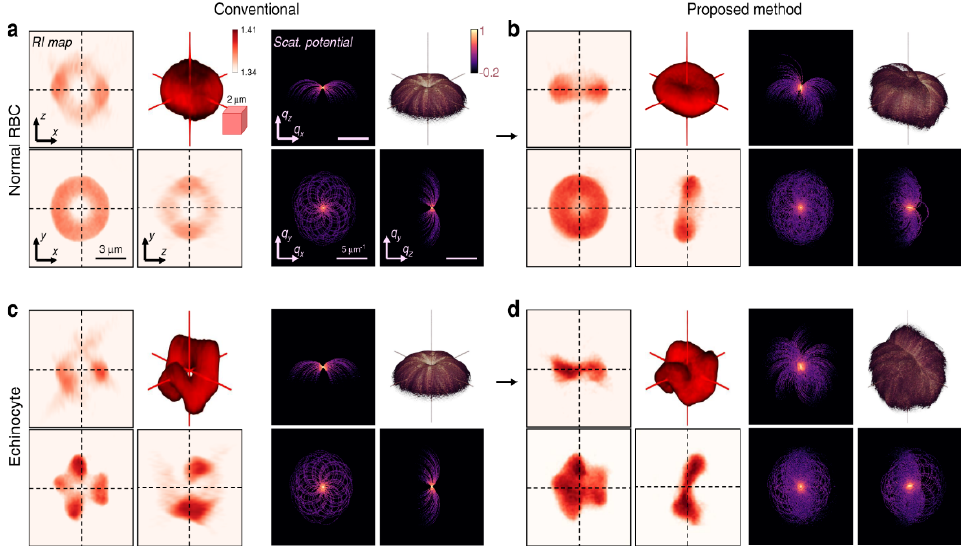
Figure 14. 3D refractive index reconstruction [144] of ( a , b ) normal RBCs and ( c , d ) echinocyte, by ( a , c ) conventional optical diffraction tomography and ( b , d ) TOMOTRAP system.